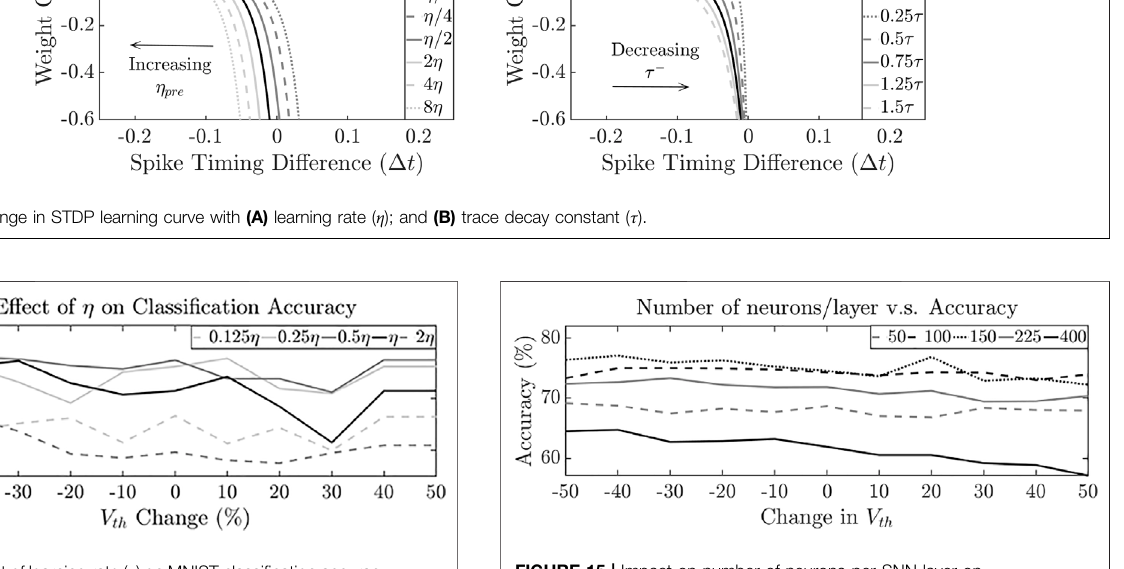
FIGURE 13 | Effect of learning rate ( η ) on MNIST classi fi cation accuracy after training 60 K samples under adversarial threshold variation.